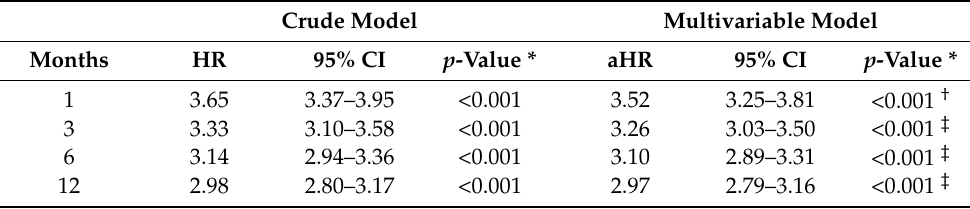
Table 4. Analysis of cumulative mortality for intracerebral hemorrhage